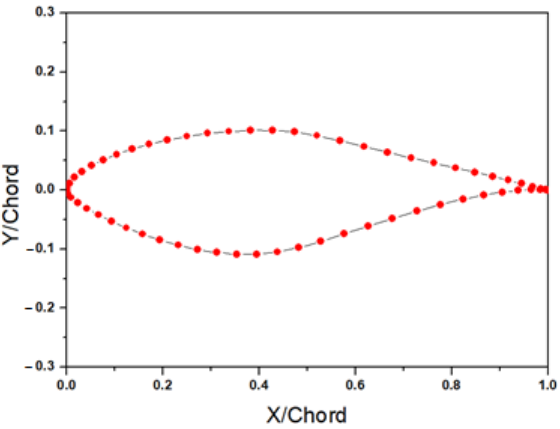
Figure 2. S809 airfoil profile with a 21% thickness.